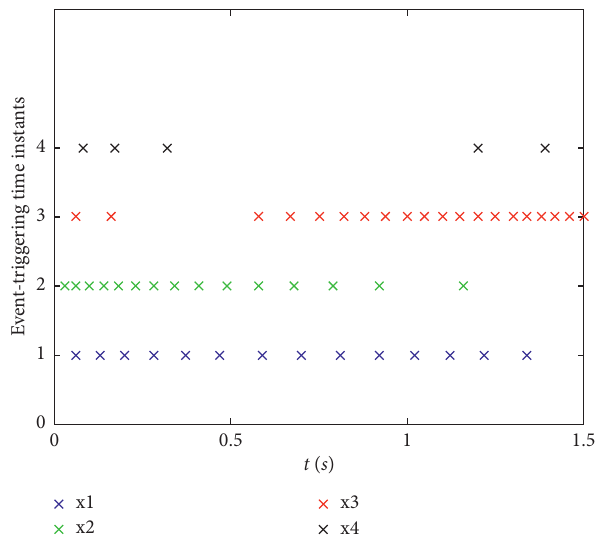
Figure 11: Event times instants for four agents in Theorem